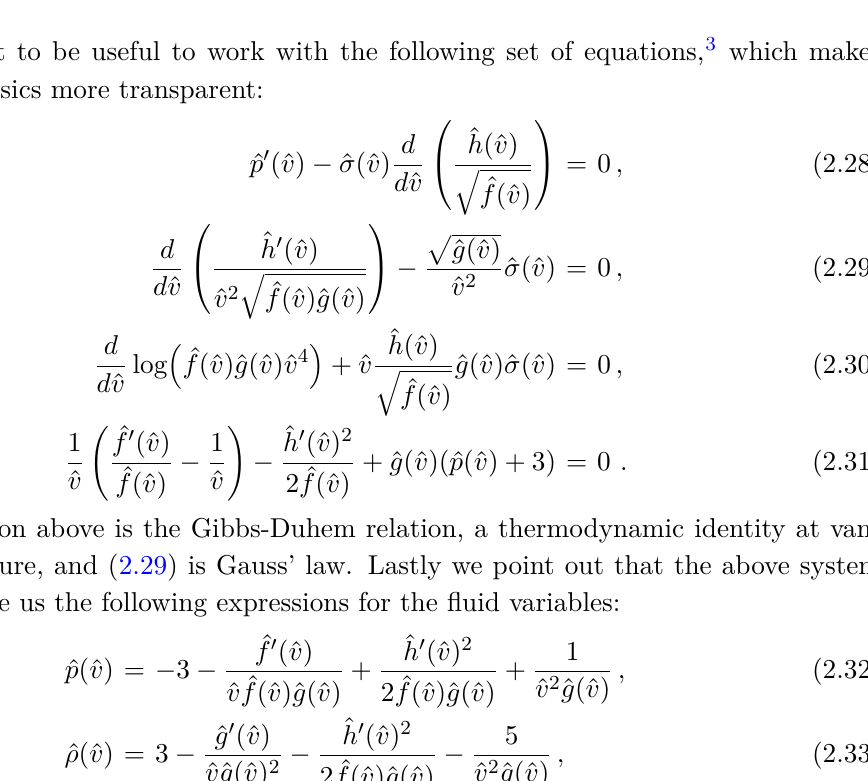
ˆ ˆ Figure 1 . The numerical results for the functions f (ˆ v ) , ˆ g (ˆ v ) , and h (ˆ v ) at low temperature ˆ T/µ = 0 . 01 and for ˆ m = 0 . 55 , β = 10 . The shaded gray denotes the bulk region where the cloud resides. Outside of this region the geometry is smoothly attached to two RN black branes, with the dashed blue and red curves corresponding to the inner and outer RN